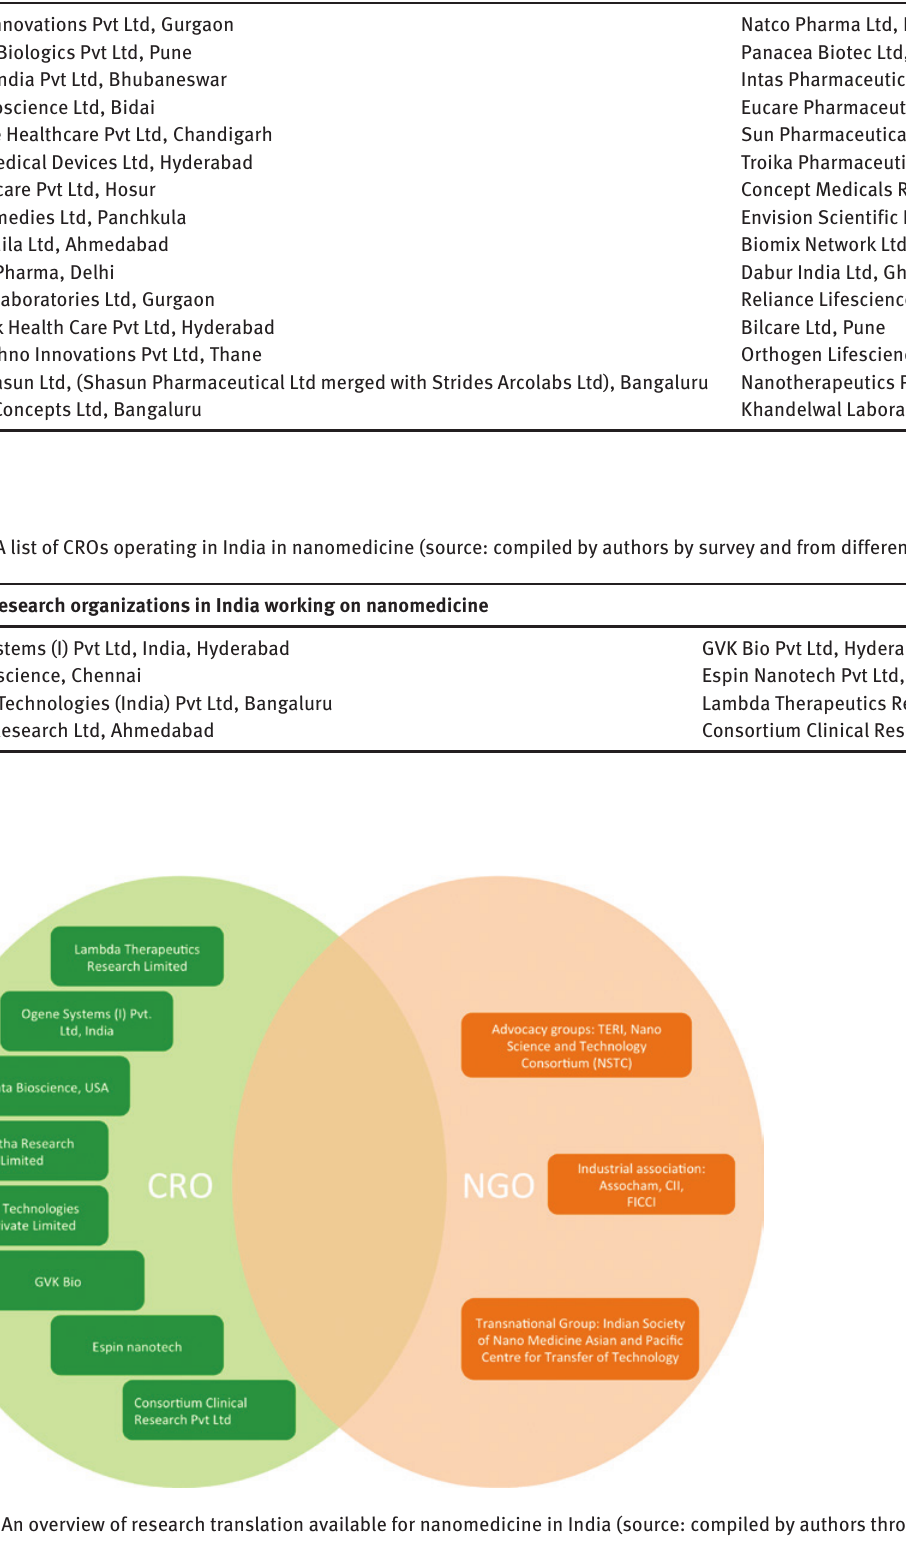
Table 5: A list of companies working in the area of nanomedicine in India (source: compiled by authors from different websites). Companies with research focus on nanomedicine